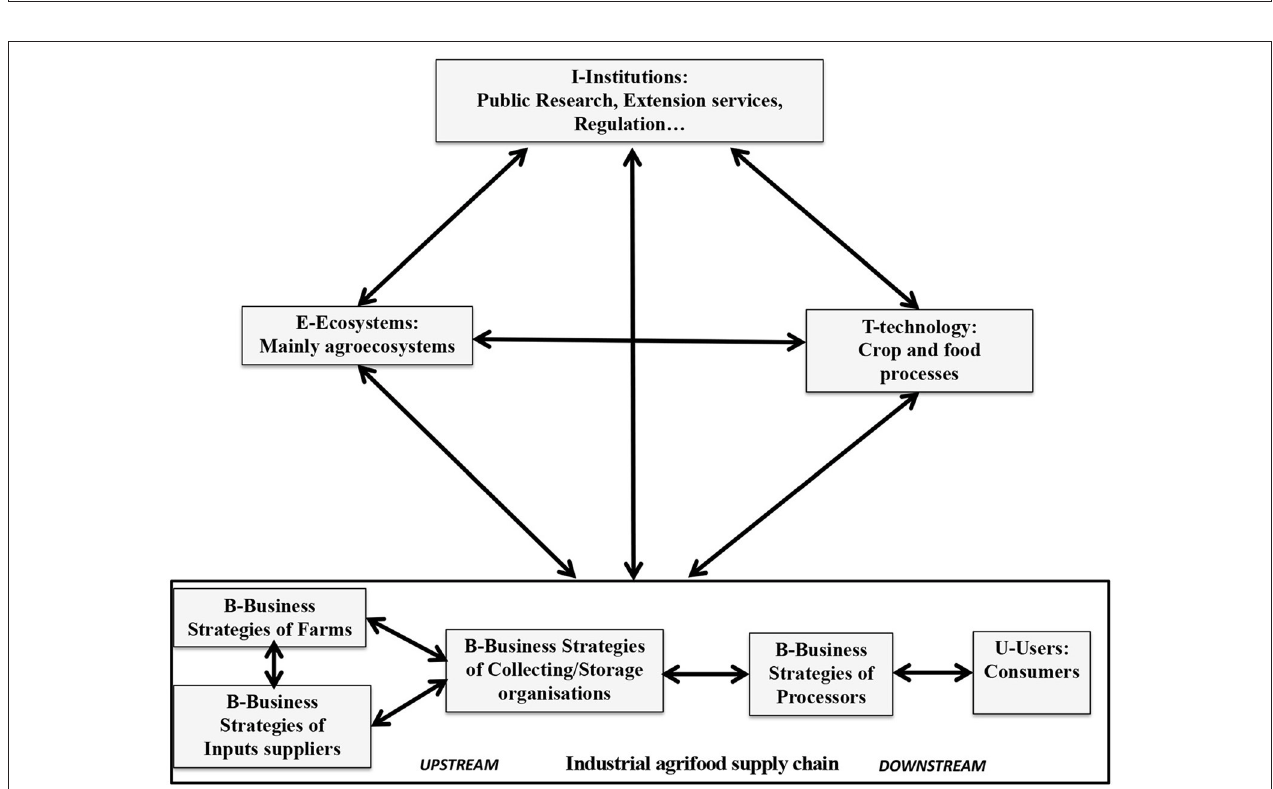
FIGURE 2 | A coevolutionary framework for conceptualizing the transition of the agrifood system.